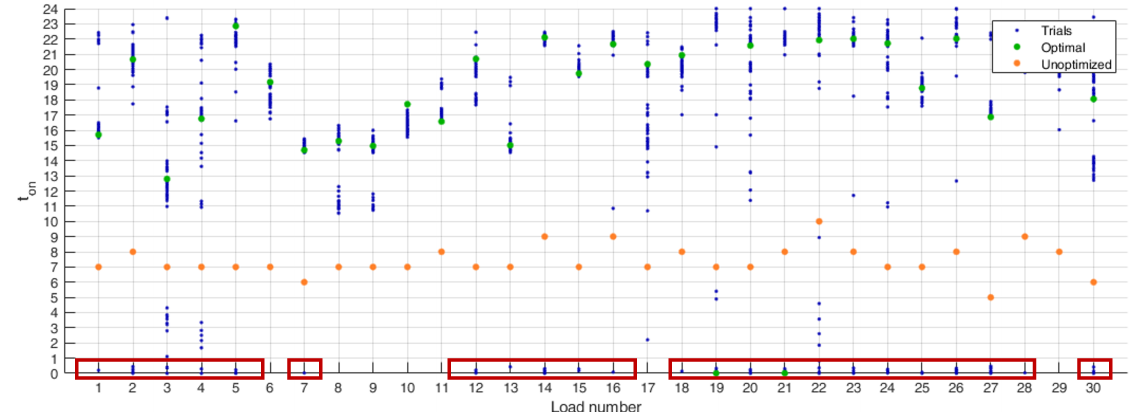
Figure 9. Representation of the optimal solutions of all the trials: the blue dots represent the value of a final solution in all 30 design variables; the green dots correspond to the best solution; while the orange ones are the unoptimised design variables. The red box highlights the solutions stacked in the local minima.